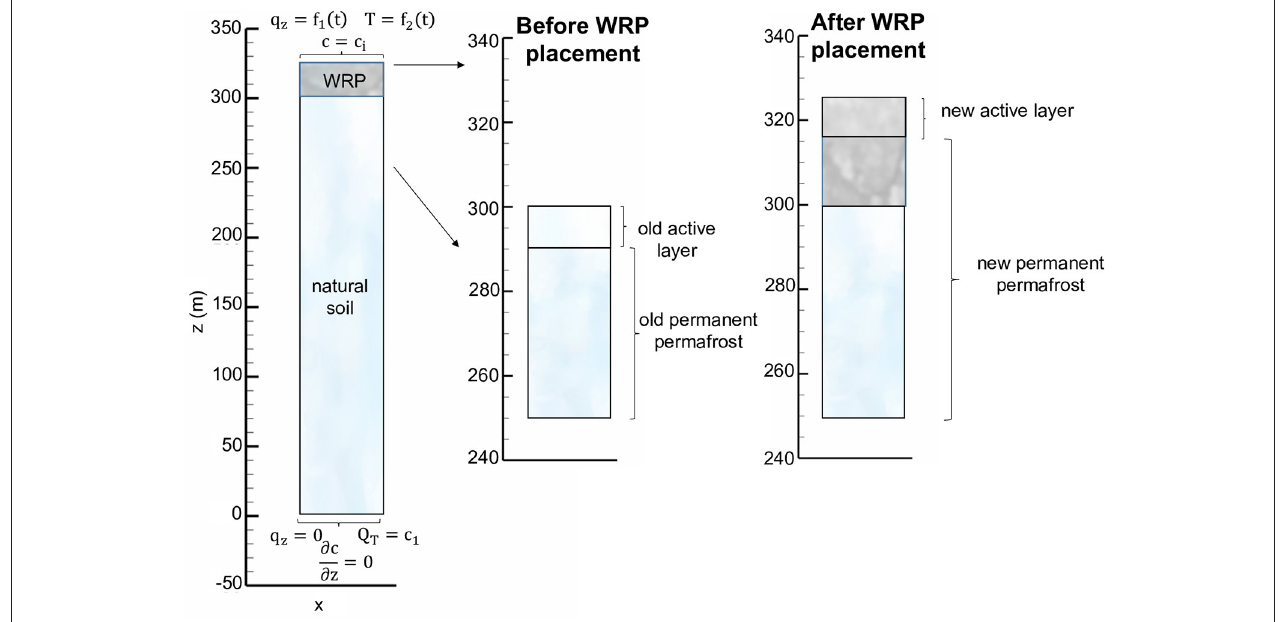
FIGURE 3 | 1D conceptual model of waste rock placed on natural soil with corresponding boundary conditions.